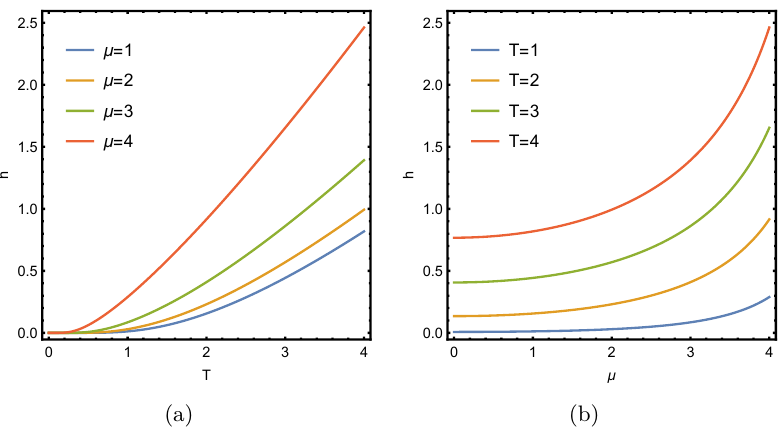
Figure 12 . The dependence of the correction term on the temperature and the chemical potential for m = 5